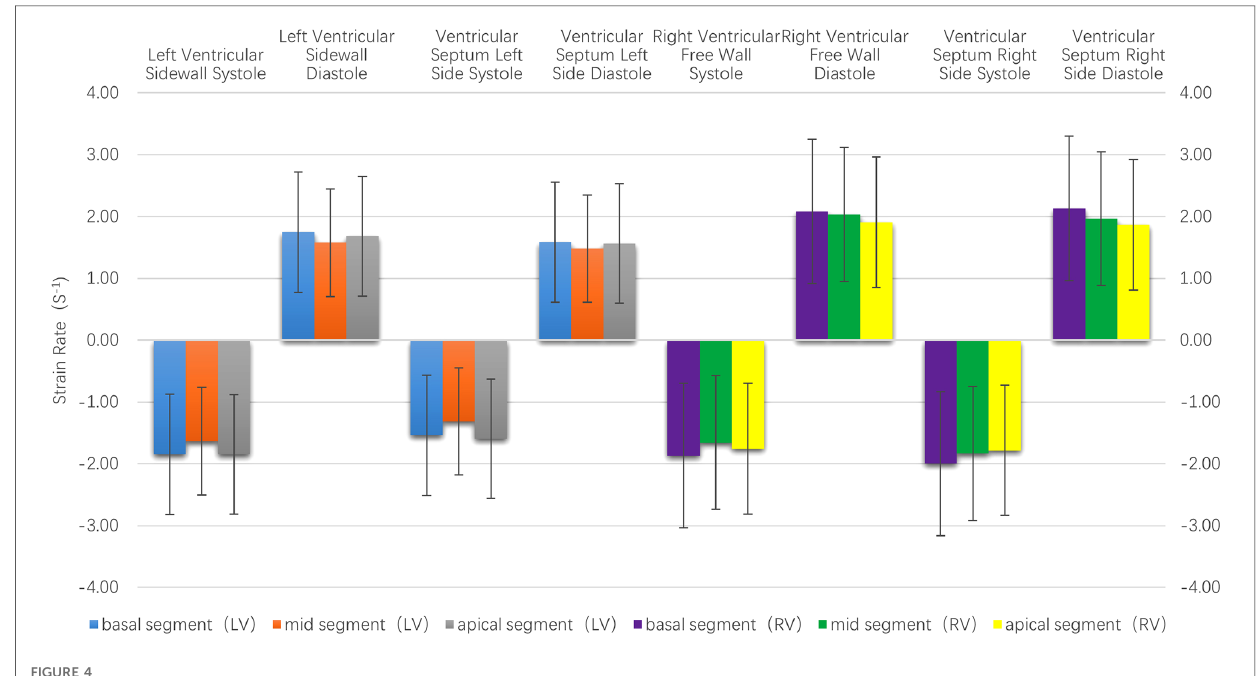
FIGURE 4 The histogram of the strain rate of the left and right ventricular wall at each segment. There were no statistically signi fi cant differences in the systolic and diastolic strain rate between the left and right ventricles at each segment. The strain rate of the right ventricle was higher than that of the left